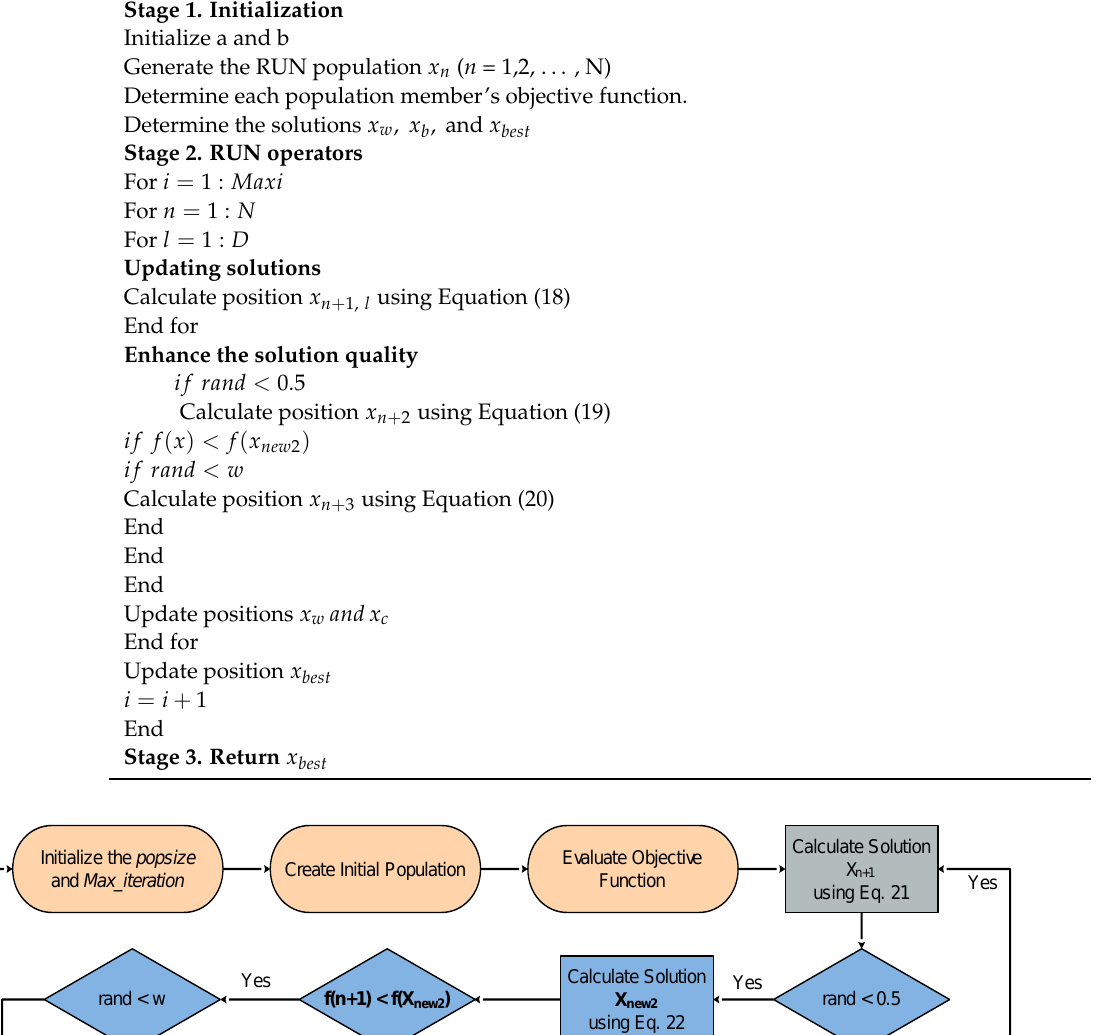
Algorithm 1. The pseudo-code of RUN [ ? ]